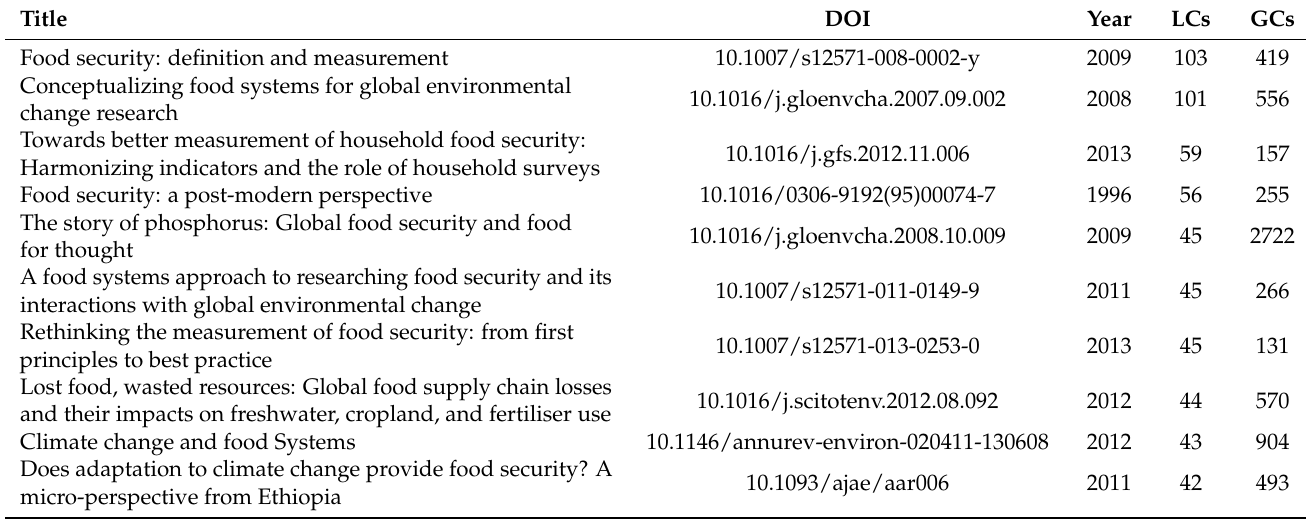
Table 1. Top 10 articles in the field of food security.